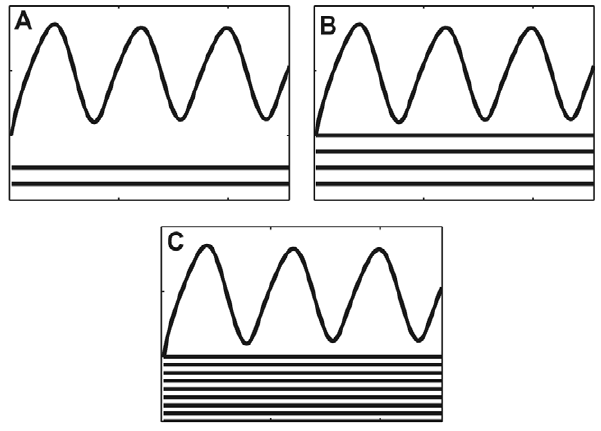
Figure 2. Three similar models. Models A, B and C are very similar; all three models contain an oscillating variable which behaves exactly the same and a different number of variables that are constant (zero entropy). Because SMETS also takes into account the difference of dimensions it can distinguish between these models: the distance A–B is the smallest (0.25), followed by the distance B–C (0.33) and then the distance A–C (0.54).